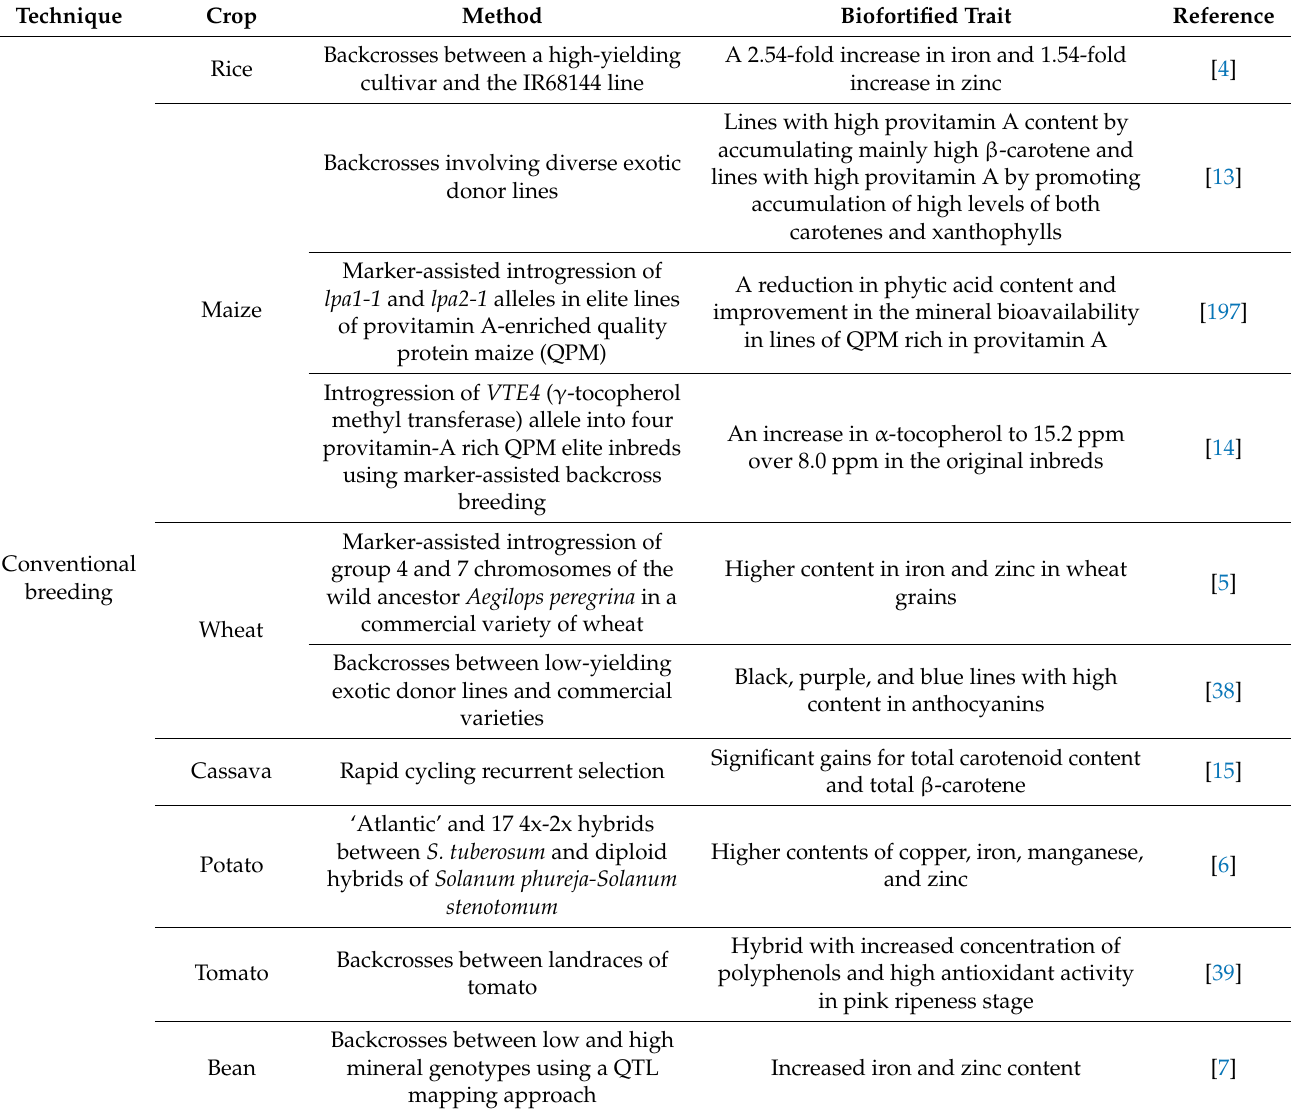
Table 3. Biofortified crops through different